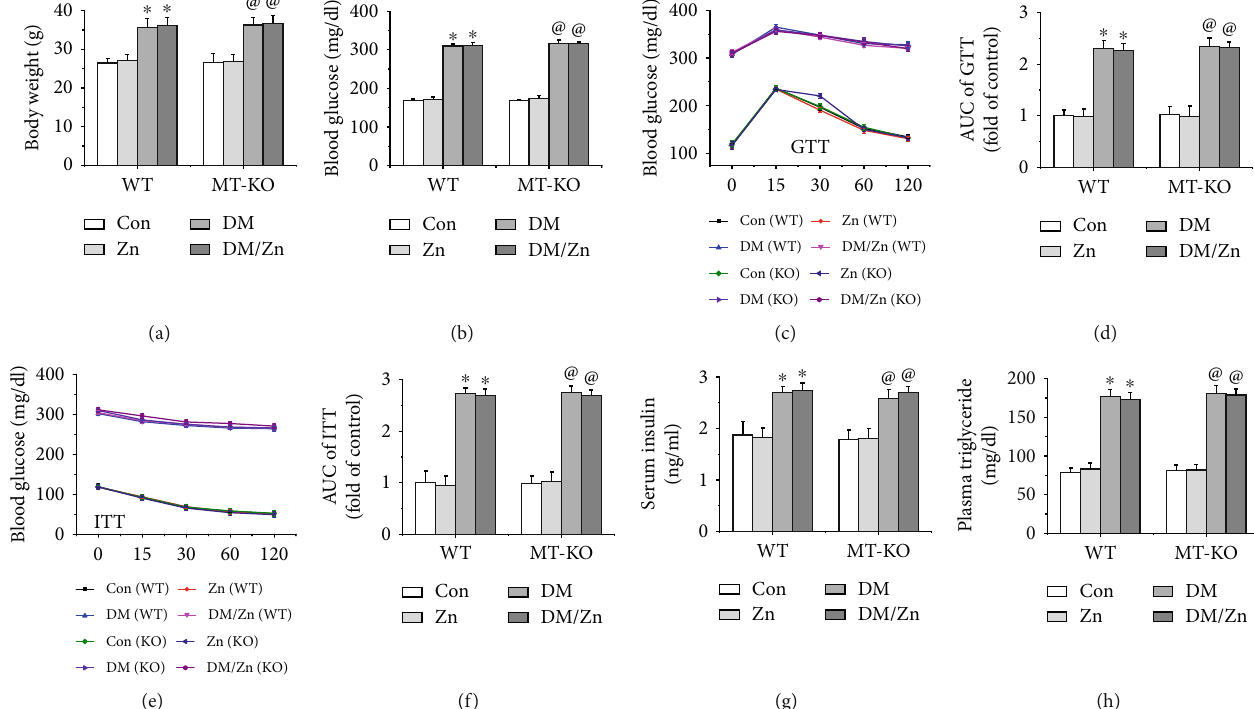
Figure 2: The e ff ect of zinc supplementation on the metabolic parameters in both WT and MT-KO mice under diabetic condition. In order to identify the role of zinc supplementation on the glucose and lipid metabolic disorders, the body weight (a), blood glucose level (b), glucose tolerance (c, d), insulin sensitivity (e, f), serum insulin level (g), and plasma triglyceride level (h) were measured. Data are presented as the mean ± standard deviation ( n = 8 /group). ∗ P < 0 : 05 vs. the control (Con) group in WT mice; @ P < 0 : 05 vs. the control (Con) group in MT- KO mice.